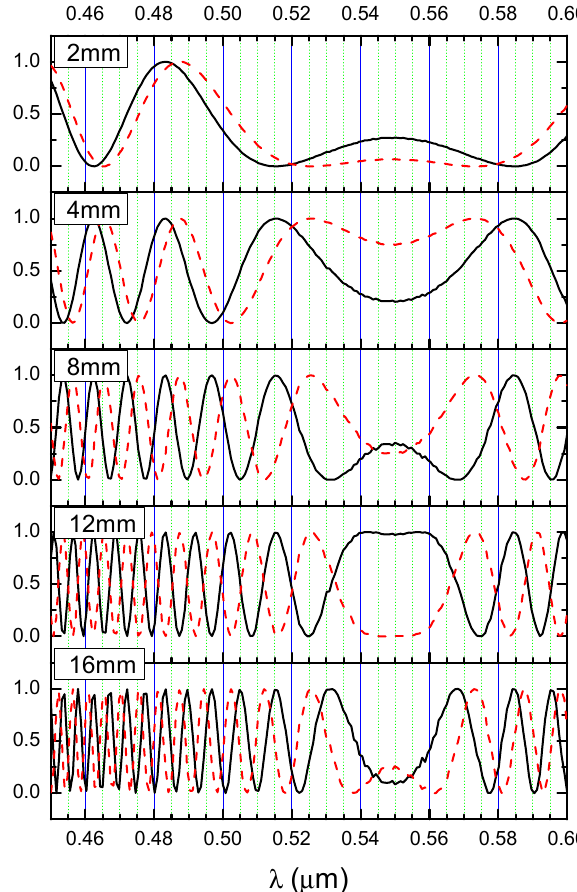
Figure 9. Light intensity distribution for different length of the propagation path. Solid line for the cover n H2O , broken line for the cover n c2 . (Solid black line for n c1 ( λ ) = n H2O , red dash line for n c2 ( λ ) = n H2O ( λ ) + 0.001.)